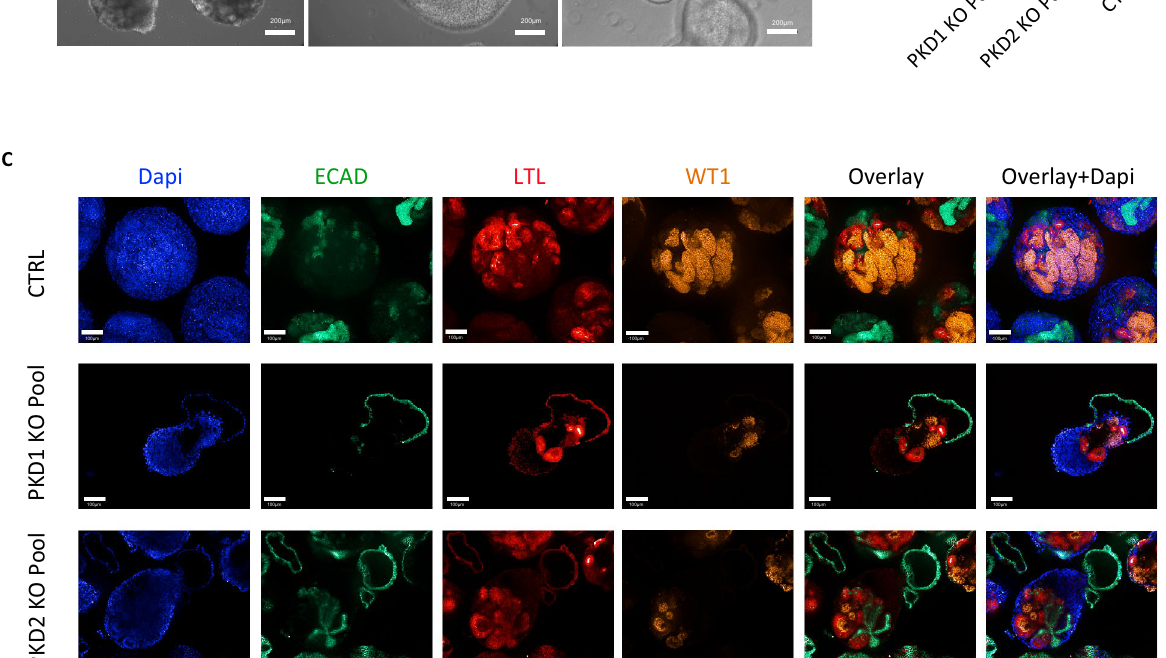
Figure 4. Cystic phenotype in kidney organoids using genetic perturbation. ( A ) Schematic outline of differentiation stages for conventional clonal knockout isolation and differentiation and speedy/direct differentiation of KO pools. ( B ) Cystic phenotype observed in organoids obtained from genetic perturbation of PKD1 and PKD2 . ( C ) The resulting kidney organoids were stained and imaged using confocal microscopy for different markers. ( D ) Quantification of cyst formation rates in PKD KO pool organoids versus isogenic unmodified organoids (CTRL) as an average of all experiments. Data are shown as Mean. Bar represent standard deviation (SD) (n = 5 separate